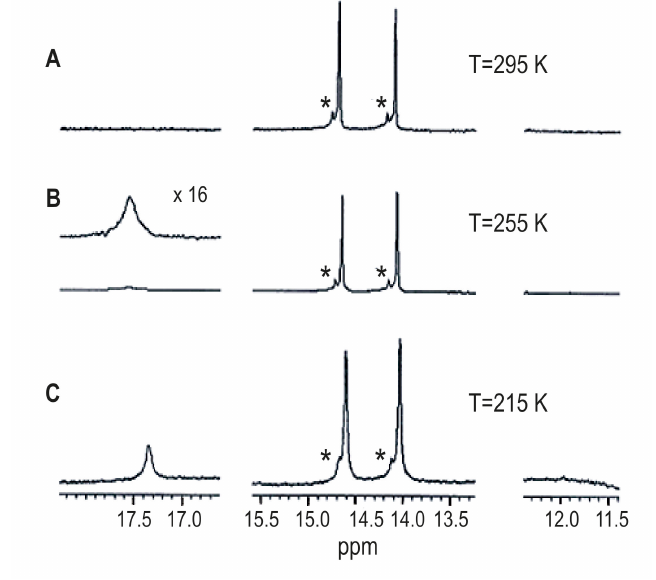
Figure 10. Variable temperature gradient 1 H-NMR spectra of hypericin in MeOH- d (anionic form 4 ): number of scans 64, 762 and 1312 for A, B and C, respectively. The asterisk denotes an unknown compound. Reprinted with permission from [31]. Copyright 2002, by Elsevier Science Ltd. (Amsterdam, The